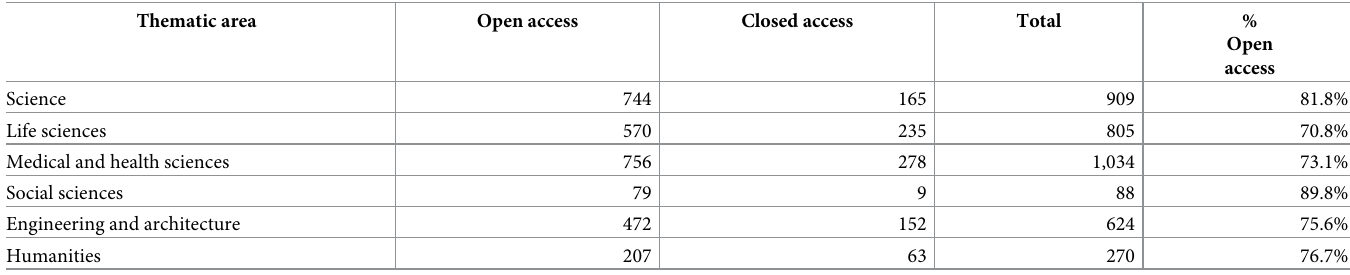
Table 5. Open and closed articles according to thematic area. Thematic